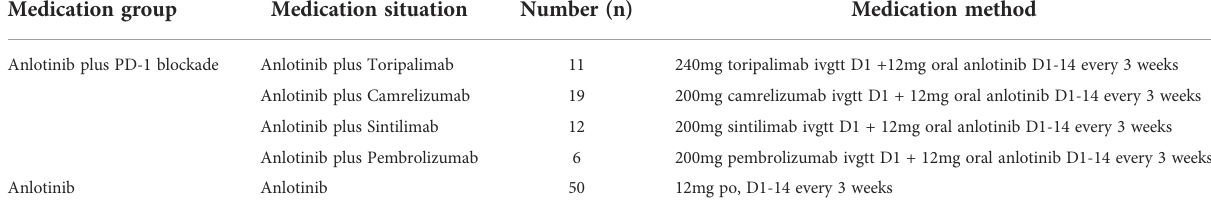
TABLE 2 The medication status of patients. Medication